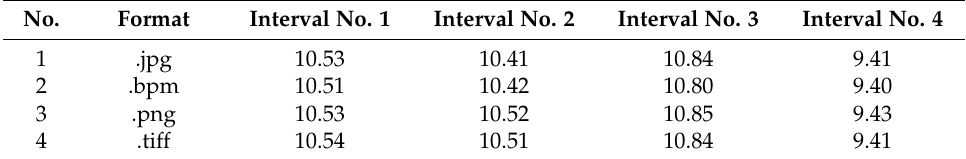
Table 8. Performance of different image formats